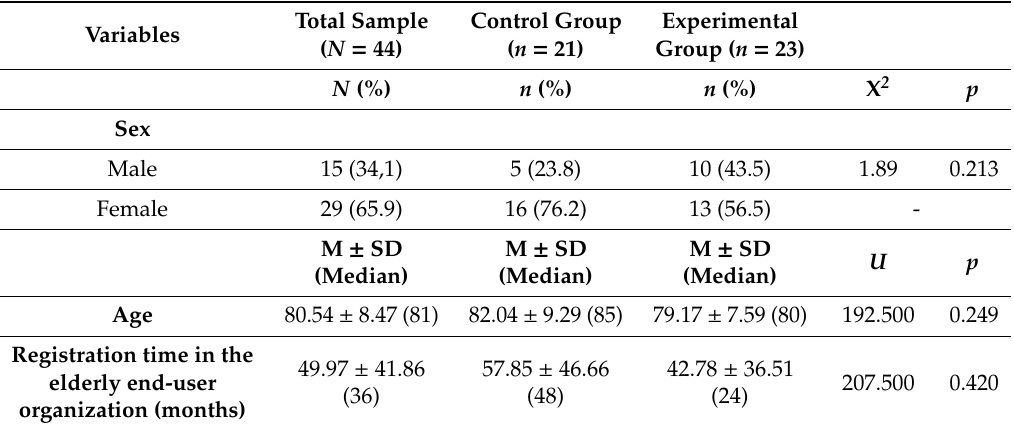
Table 1. Baseline Characteristics of the study